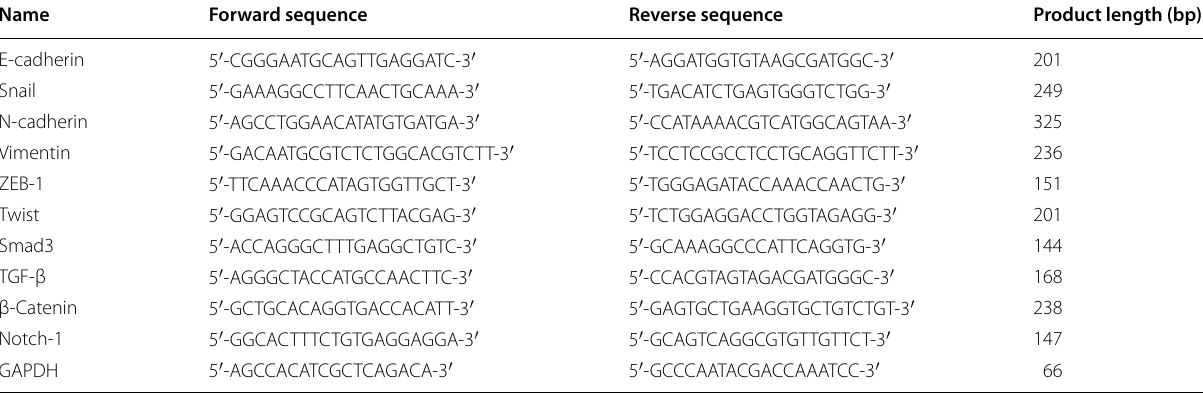
Table 1 Primers for semi-quantitative reverse transcription-polymerase chain reaction (RT-PCR) and quantitative real- time